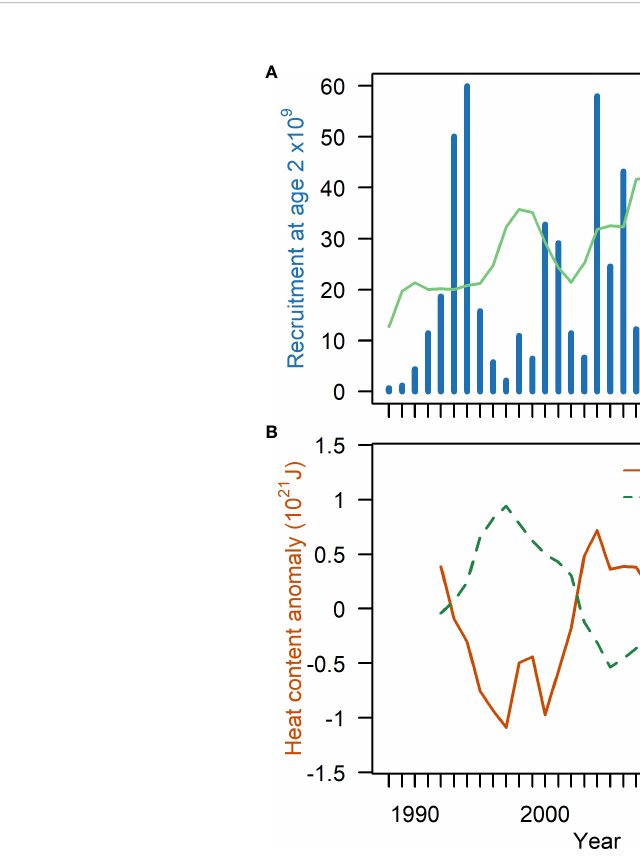
FIGURE 1 (A) Spawning stock biomass (SSB) and recruitment at age 2 of Norwegian spring-spawning herring (source: ICES advice 2021). (B) Heat content anomaly (brown solid) and freshwater anomaly (green stippled) in the Norwegian Sea from surface to 400m depth 1992-2015. Redrawn with permission and data from Asbjørnsen et al., 2019 based on ECCOv4